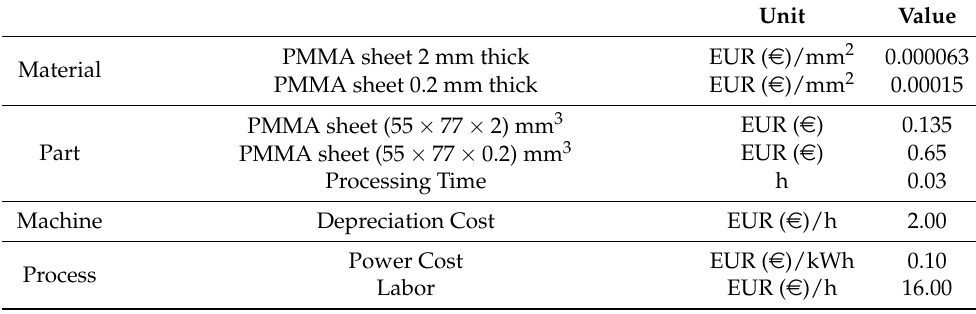
Table 3. Cost model input parameters considered for the PMMA- µ SPT .